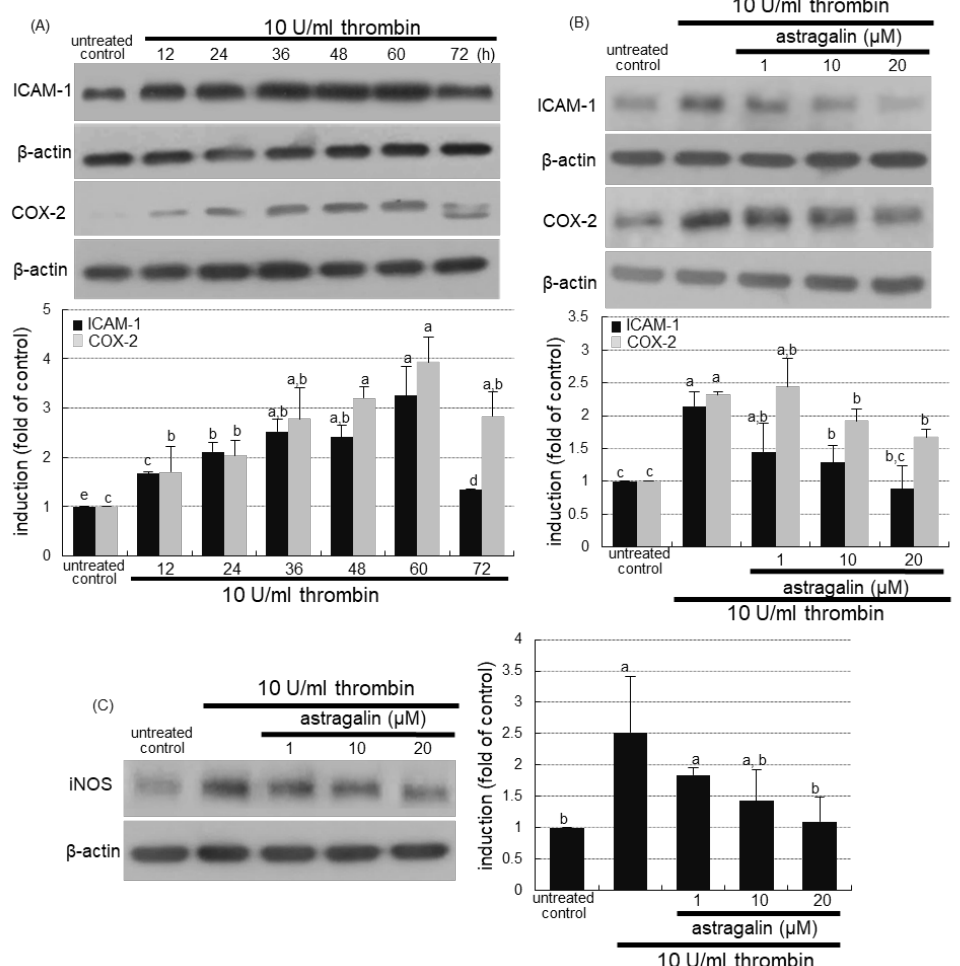
Figure 5. Temporal induction of alveolar inflammatory mediators by thrombin ( A ) and blockade of their induction by astragalin in thrombin-treated A549 cells ( B , C ). Alveolar epithelial cells were incubated in media containing 10 U/mL thrombin in the absence and presence of 1 –20 μM astragalin for up to 72 h. Cell lysates were subject to Western blot analysis with a primary antibody against ICAM-1, COX- 2, or iNOS. β -Actin protein was used as an internal control. The bar graphs (mean ± SEM, n = 3) represent quantitative results of the upper or left bands obtained from a densitometer. Values in bar graphs (same achromatic colored) not sharing the same lower case alphabet letter indicate a significant difference at p < 0.05.